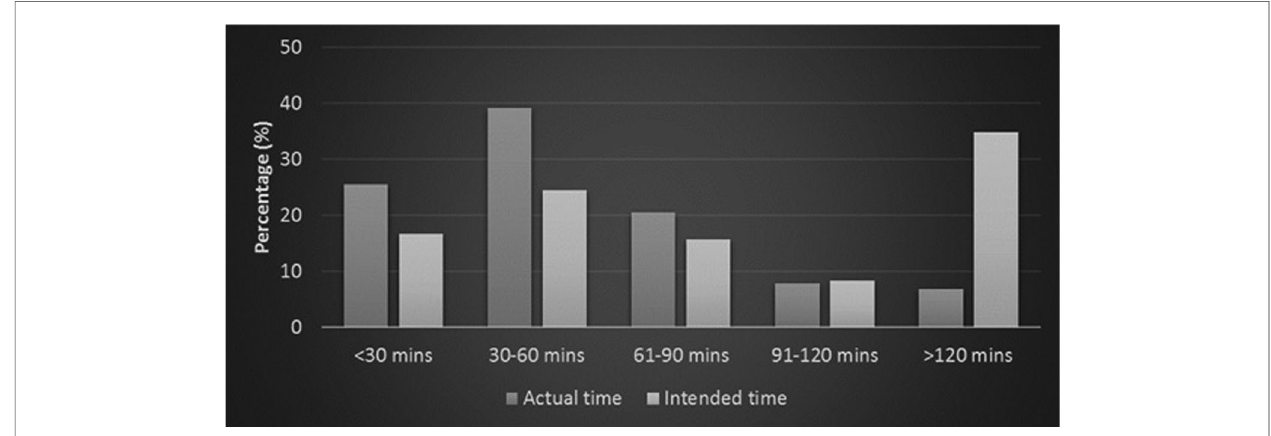
FIGURE 1 | The distribution of the actual and intended time periods to use continuous professional development resources on the internet.